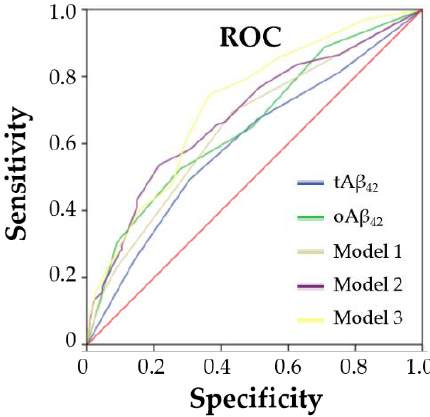
Figure 4. AUC for predicting the presence of CSVD. Model 1: CSVD = −0.594 + 0.865 × hypertension + 0.990 × previous stroke; Model 2: CSVD = −1.343 + 0.254 × tAβ42 + 0.864 × hypertension+ 0.974 × previous stroke; Model 3: CSVD = −1.785 + 0.405 × oAβ42 + 0.864 × hypertension+ 0.947 × previous stroke.